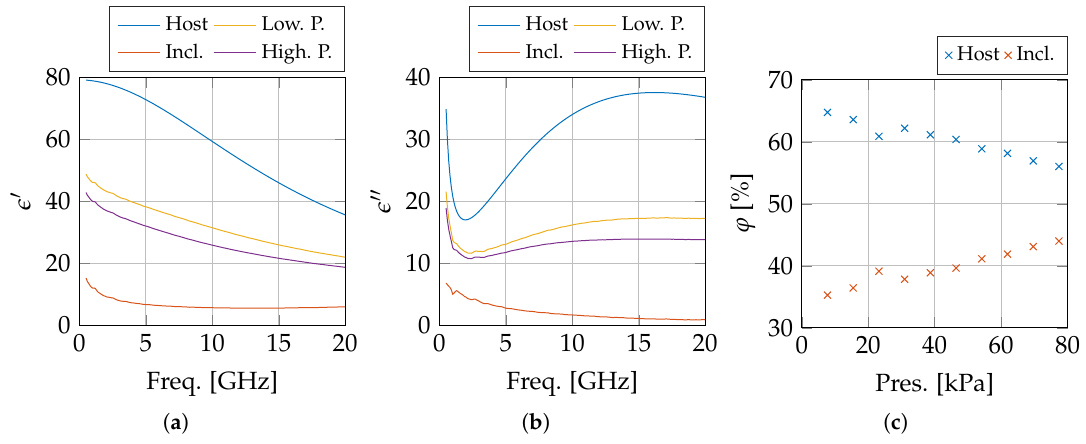
Figure 8. The dielectric properties of the host medium, the inclusions, and the compared to the measurements at 7.74 kPa (Low. P.) and 77.4 kPa (High. P.) with the real and imaginary part in, respectively, ( a , b ). The calculated volume fractions ϕ are displayed in ( c